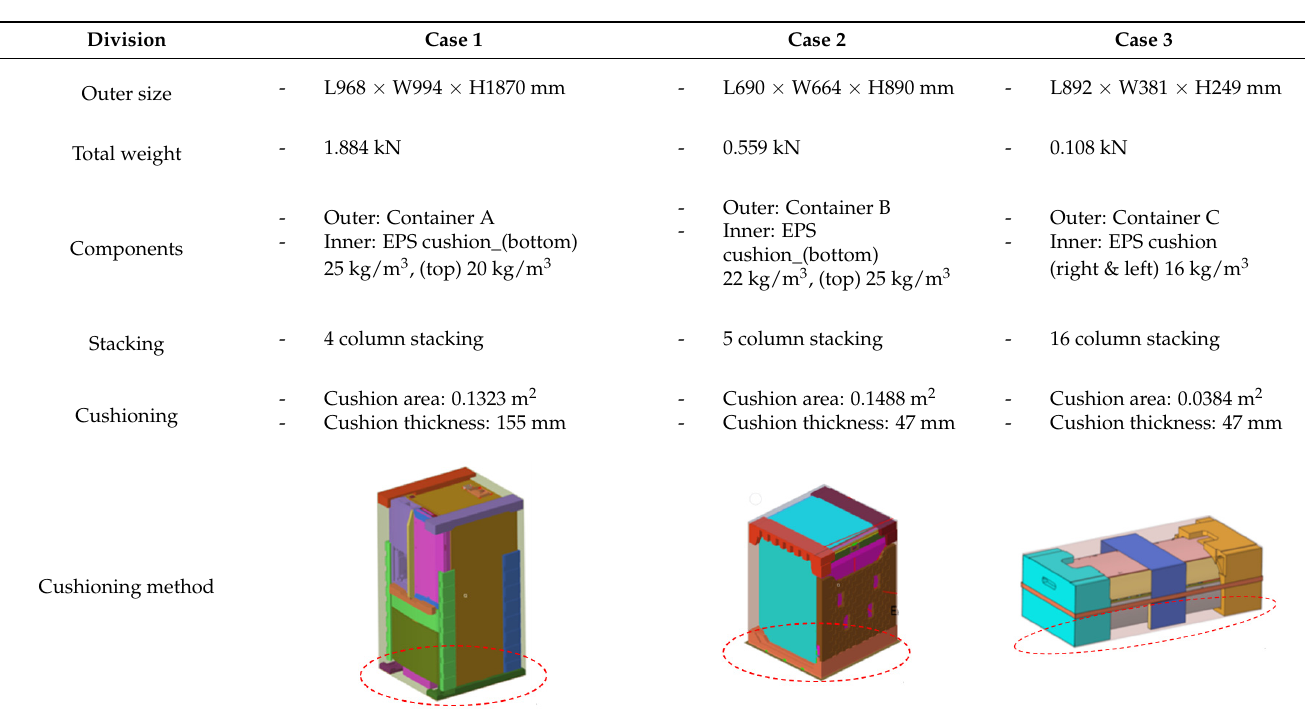
Table 1. Details of the target packages.